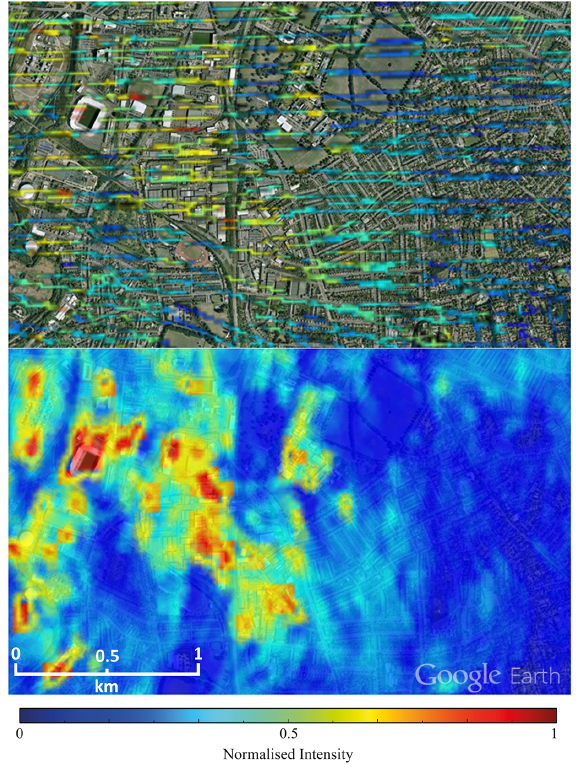
Figure 4. Google Earth overlays of the raw intensity (442.7nm) with 20m resolution with (bottom) and without (top) along-track linear interpolation and 2 × 2 grid cell smoothing. The pixel coor- dinates derived in Sect. 3.1 were assumed to be the centre of the gridded data in the top plot.